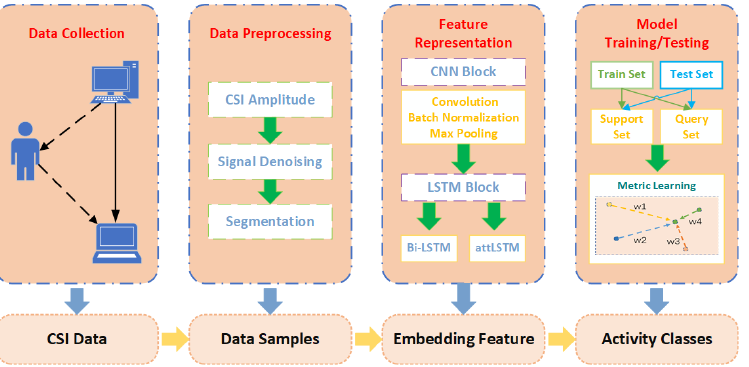
Figure 10. The workflow of